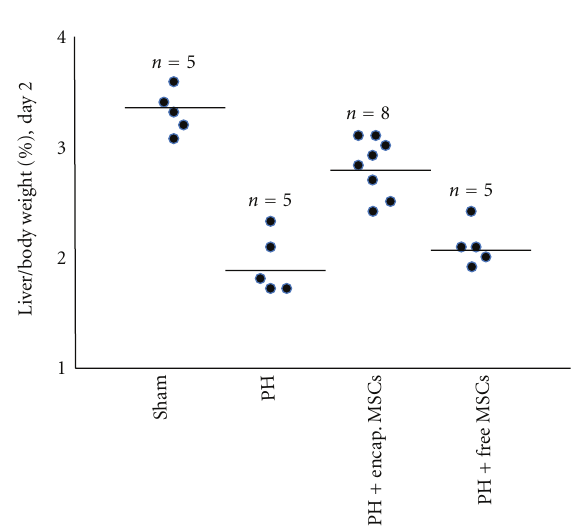
Figure 2: Remnant liver wet weight on day